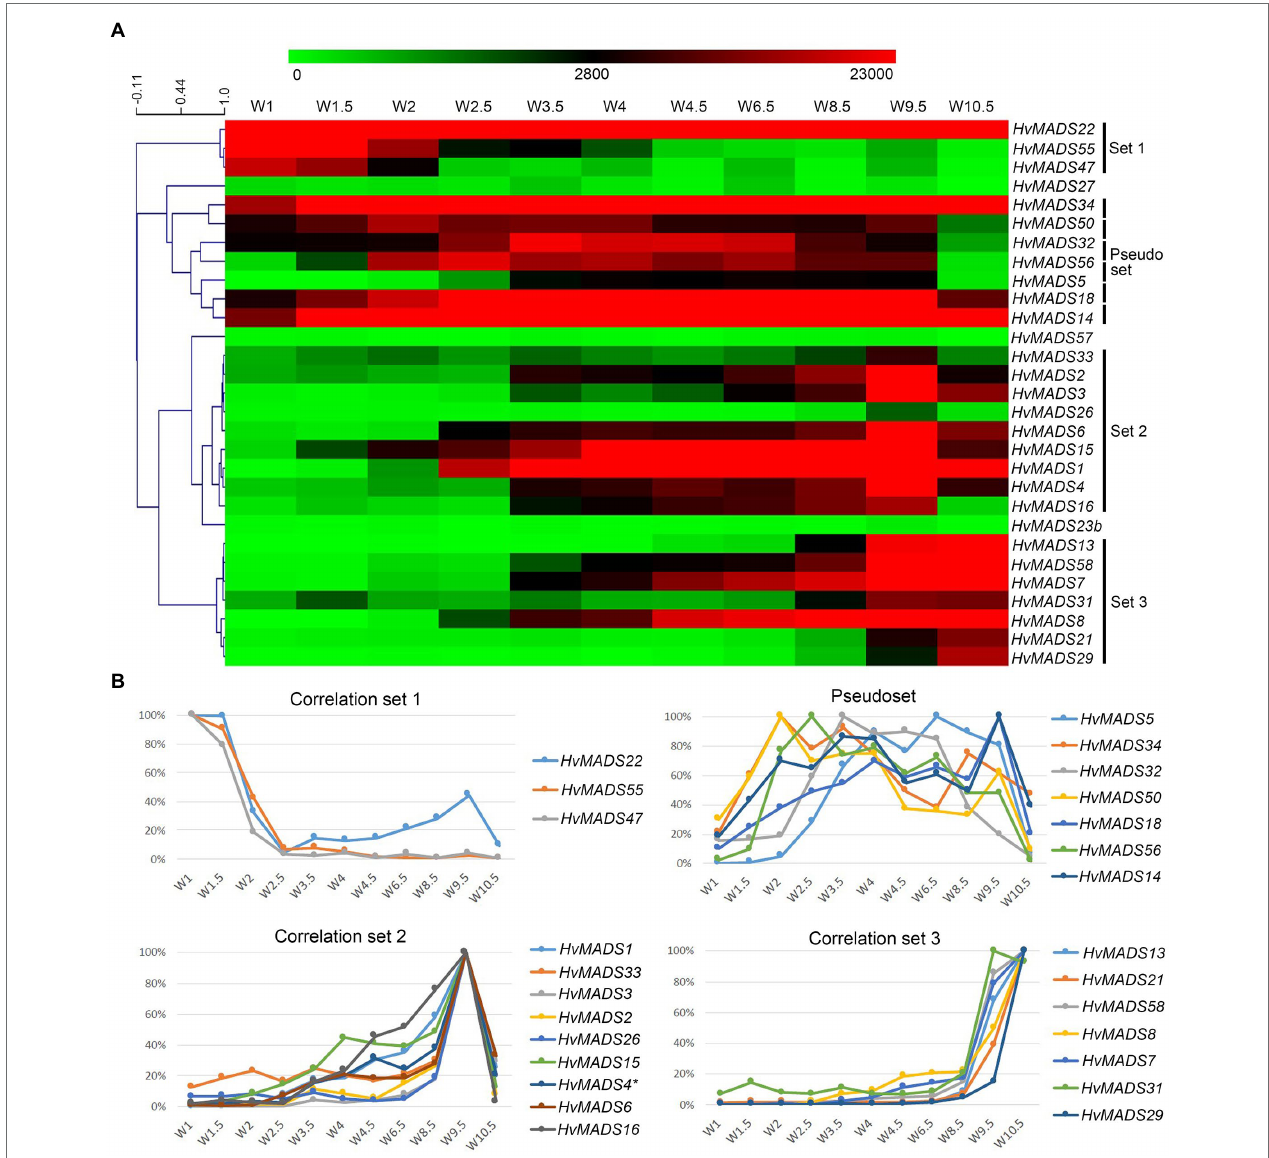
FIGURE 6 | Transcript profiles of MIKCc MADS-box genes can be grouped into correlation sets. (A) Pearson correlation of time course expression reveals three sets and a pseudoset. Expression is represented on a logarithmic colour scale, where the maximum value is capped to provide the best visual contrast in the data set spanning orders of magnitude. Correlation tree and scale bar are presented on the left side. (B) Relative expression profiles through inflorescence development of the MADS-box genes within each correlation